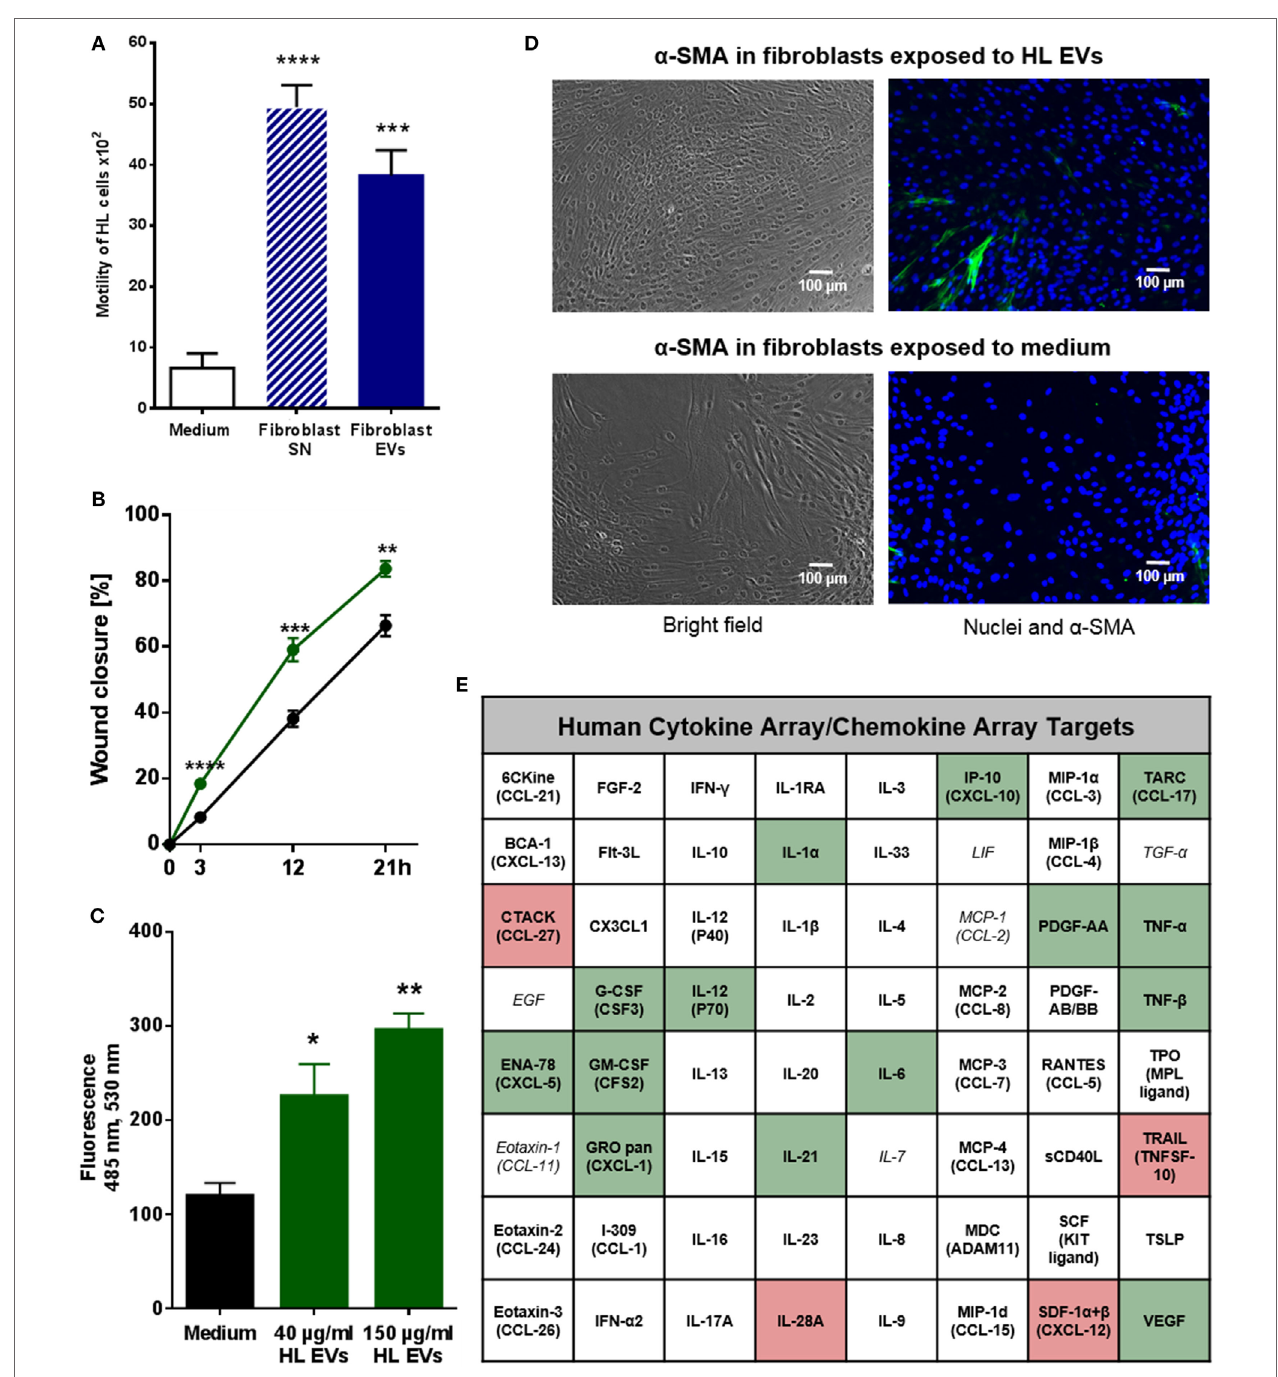
FigUre 2 | Extracellular vesicles (EVs) promote migration of Hodgkin lymphoma (HL) cells and HL EVs can alter the phenotype of fibroblast cells. (a) Transwell migration assay (8 µm pores): HL cells were exposed to supernatant from fibroblast cells or EVs for 26 h. Statistical significance was calculated with one-way ANOVA and Tukey’s multiple comparisons test (presented is mean + SEM, four biological replicates; *** p ≥ 0.001; **** p ≥ 0.0001). (B) Scratch assay: 24 h wound closure of fibroblast cells exposed to HL EVs (green) or medium (black). Student’s t -test was performed to check for significant differences between both treatments (mean ± SEM, n = 3; * p ≥ 0.05; ** p ≥ 0.01). (c) Chemotaxis assay: migration of labeled fibroblast cells through Neuroprobe ChemoTx plates (5 µm pores) exposed to medium, 40 or 150 µg/ml HL EVs. Statistical assessment was performed with one-way ANOVA and Tukey’s multiple comparisons test (data are presented as mean + SEM, n = 4; * p ≥ 0.05; ** p ≥ 0.01). (D) Exemplary bright field and fluorescence pictures of a scratch assay after 24 h exposure of fibroblasts to 100 µg/ml ( ≈ 1 × 10 9 EVs/ml) HL EVs or medium. Nuclei stained with DAPI (blue), fibroblast cells with α -SMA (green). This experiment was performed in three independent replicates. (e) Human 64-Plex chemokine array: quantification of chemokines/cytokines after 24 h in the supernatant of fibroblasts in presence or absence of HL EVs. Not detected cytokines/chemokines are depicted in italic letters; abundant factors are in bold; enhanced expression is highlighted in green, whereas red boxes indicate lower expression after exposure to HL EVs. Statistical differences in abundance of chemokines/cytokine were determined using Student’s t -test (three independent